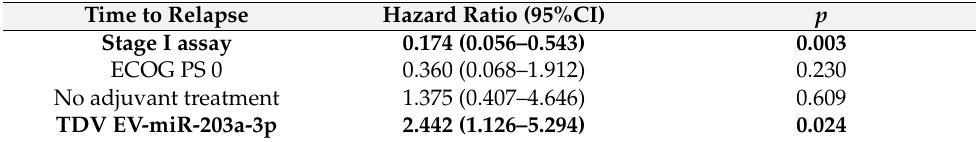
Table 4. Cox multivariate analysis for TTR in the overall